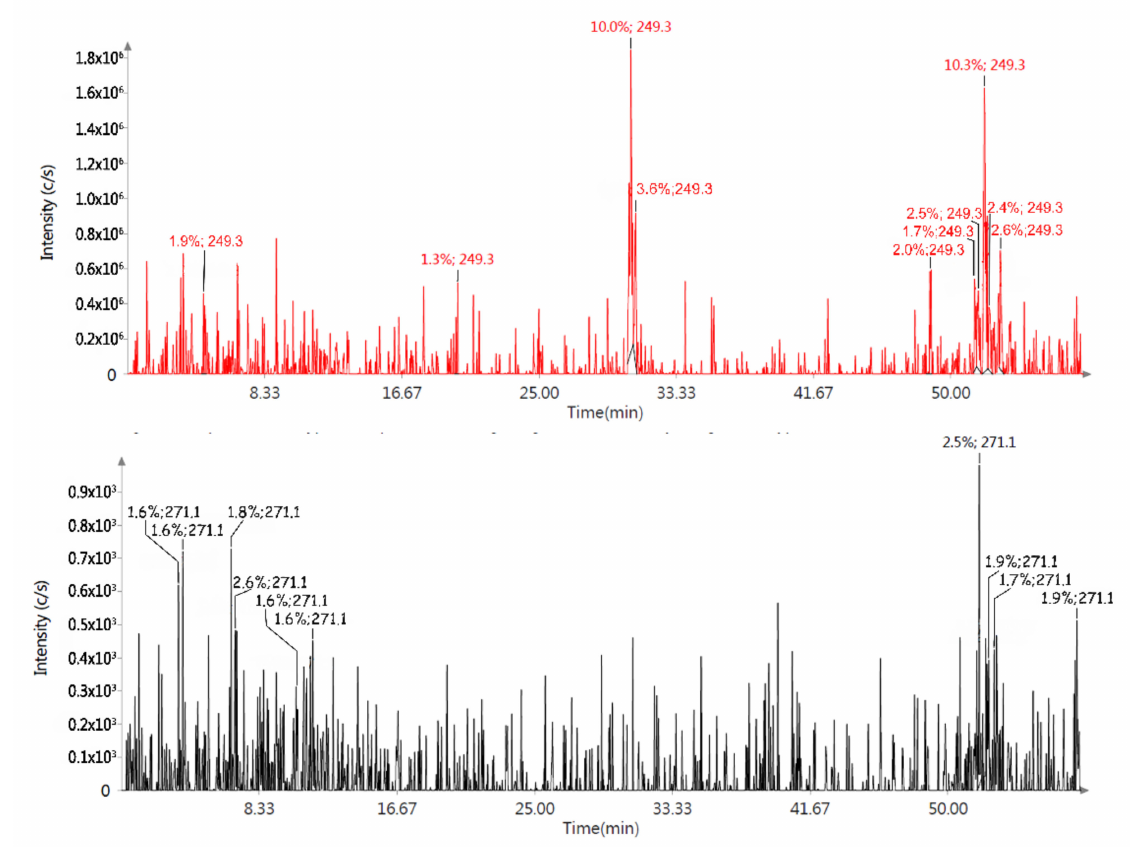
Figure 1. Qualitative mass spectrometry (MS) analysis conducted on the extract mixture. The MS analysis was conducted in positive ion mode (m/z scan mode: 100–1200), and the m/z ratios of 249.3 and 271.1 were monitored to identify the parthenolide. The present m/z ratios were selected on MassBankEurope